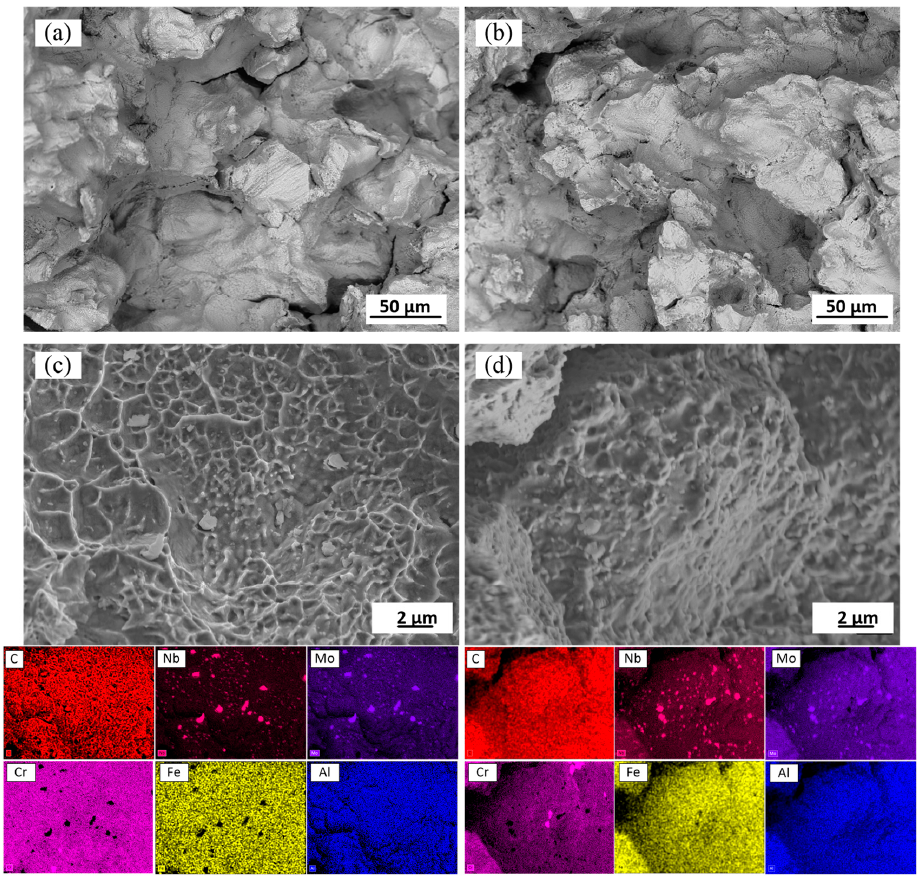
Figure 14. Fracture surface of the solution-treated Alloy 1 ( a , c ) and Alloy 2 ( b , d ) after tensile testing at 760 °C; EDX elemental maps.